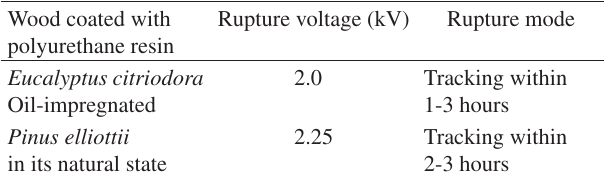
Table 12. Tracking and erosion resistance under severe environmental conditions. Wood coated